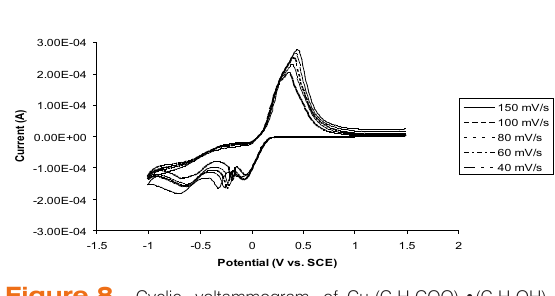
Figure 8. Cyclic voltammogram of Cu 0.00.51.01.52.02.53.03.5